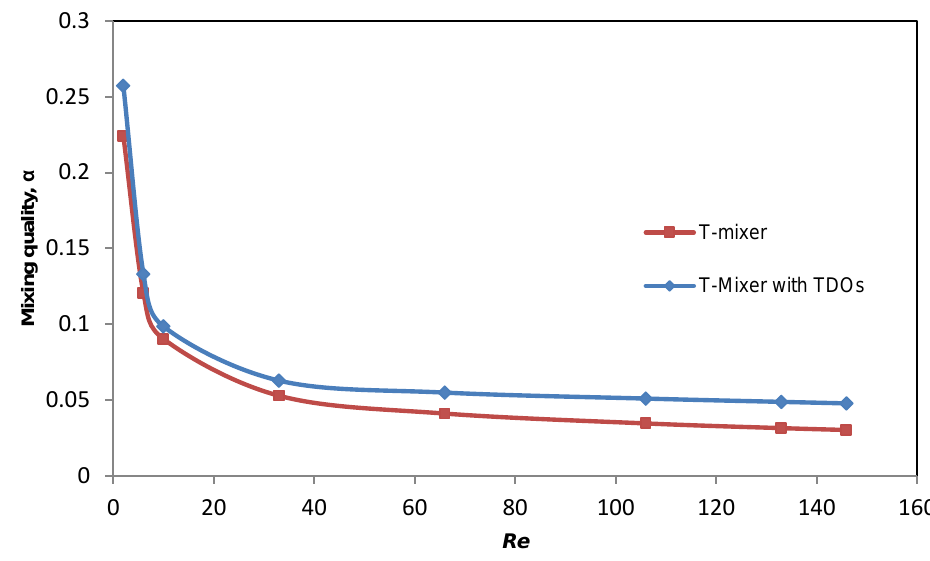
Figure 10. Variation of mixing quality with Re